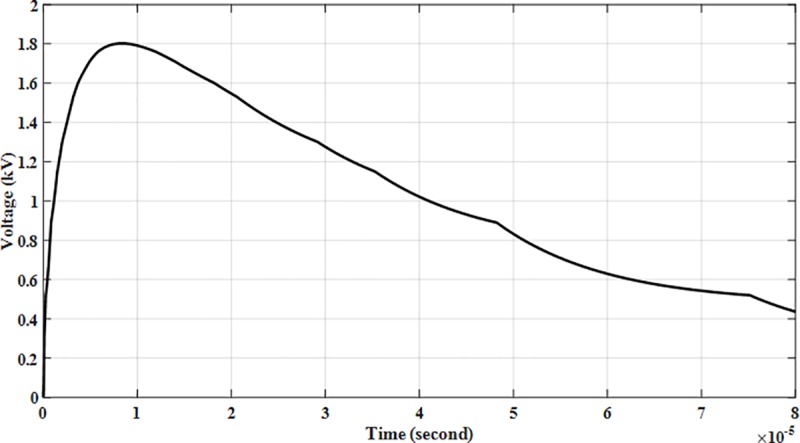
Arrester discharge voltage at In, 20 kA.